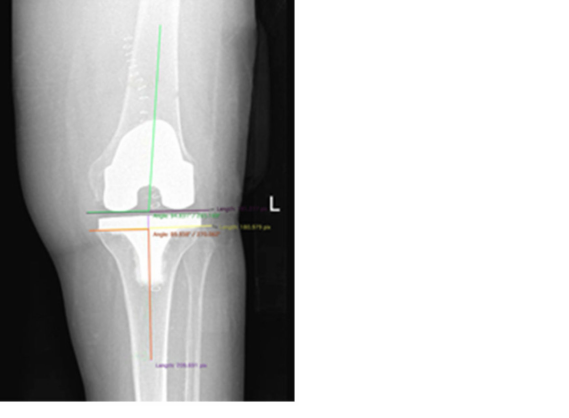
Figure 2. Coronal alignment measurement method for the femoral and tibial